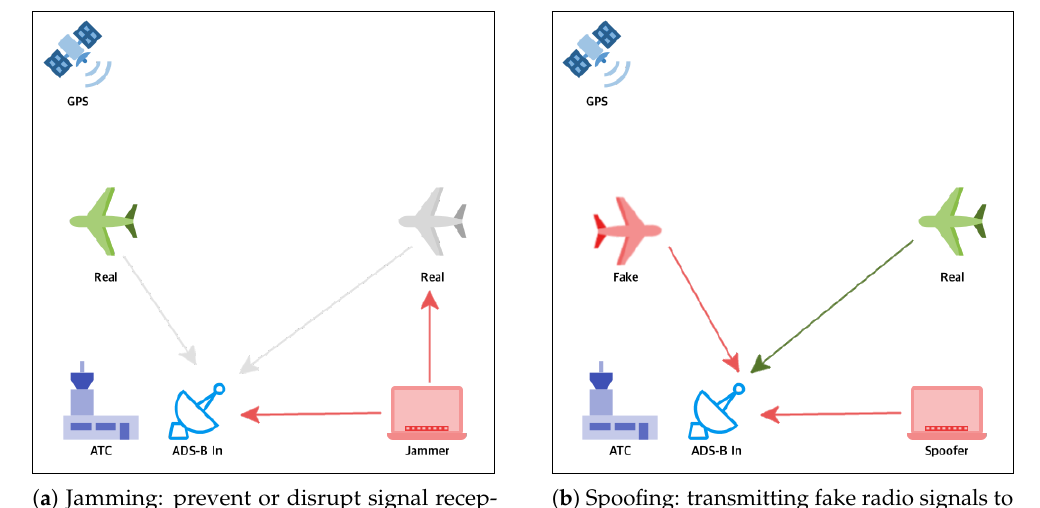
Figure 2. Jamming and spoofing cyberattacks on flight